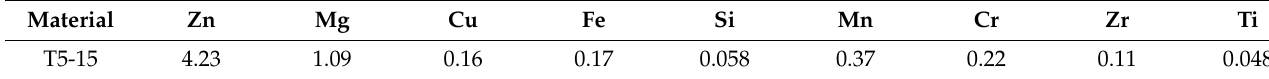
Table 1. Chemical composition of the 7B05 aluminum alloys (wt%).